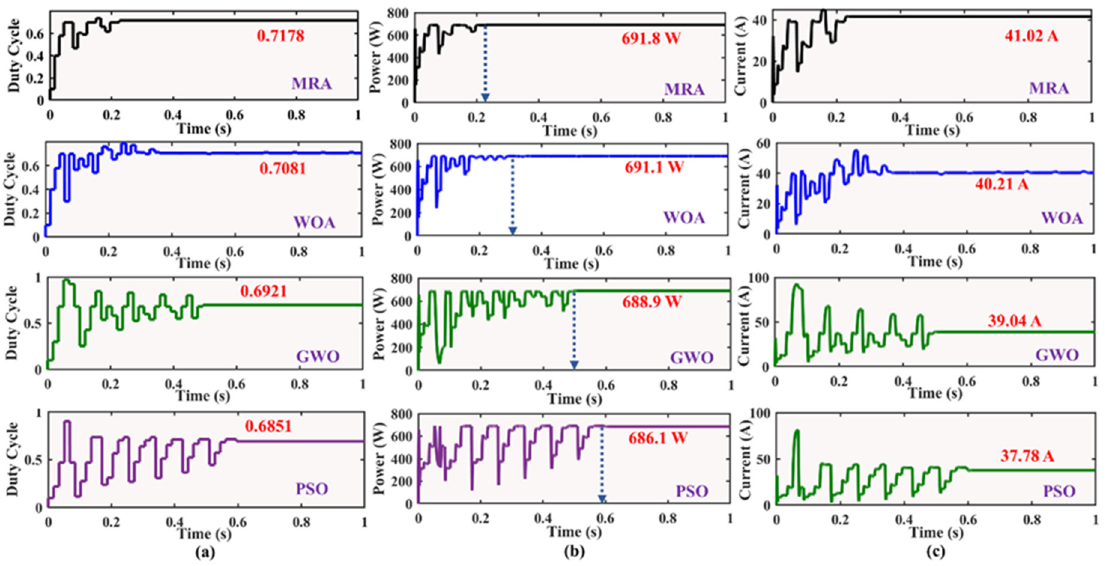
Figure 7. Comparative analysis of all techniques for Case 1 (a) Duty Cycle Variation (b) Power Tracking (c) Current Variation